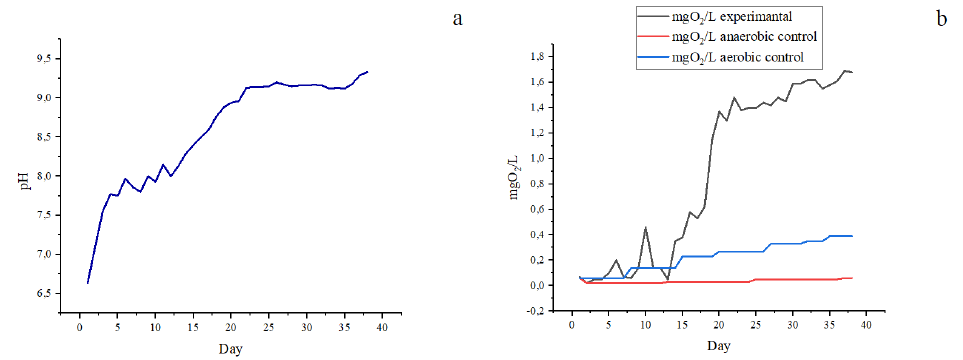
Figure 4. pH values during wastewater treatment in the main experiment ( a ). Wastewater oxygen content during microalgae cultivation in the bioreactor (black), anaerobic (orange), and aerobic (blue) control ( b ).